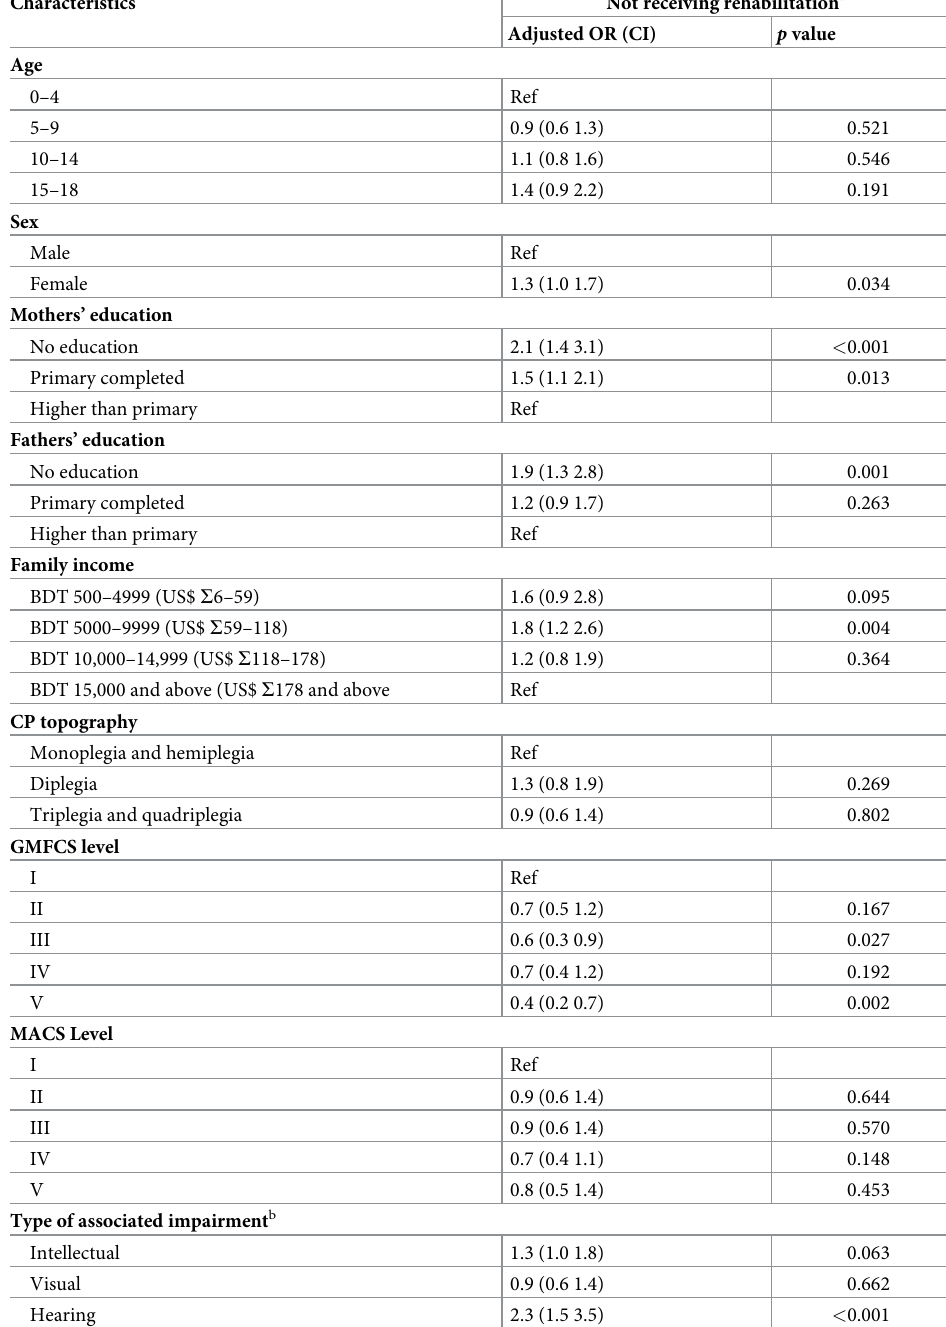
Table 5. Predictors of not receiving rehabilitation service for children with CP in the BCPR